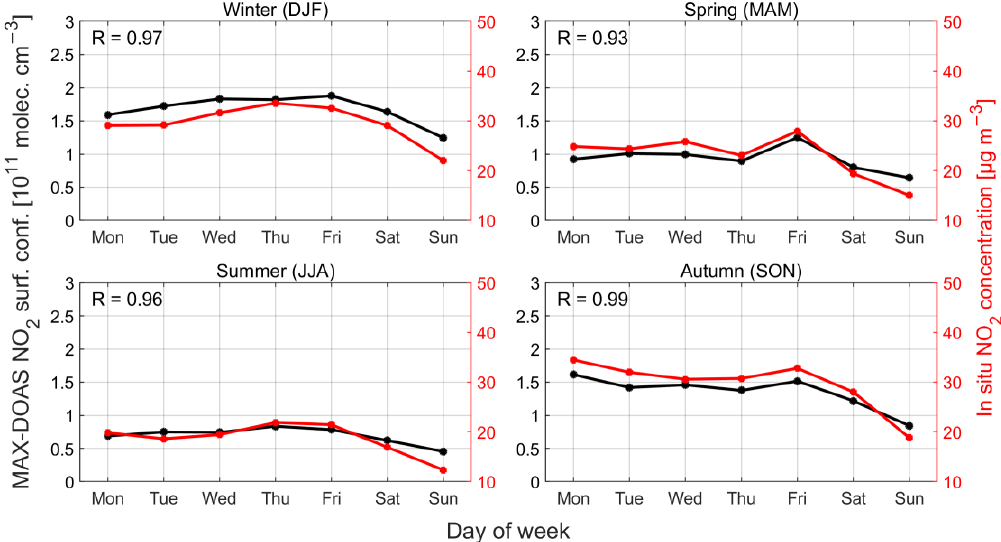
Figure 4. The day of week variability of NO 2 surface concentrations revealed by the MAX-DOAS (black) and the in situ (red) measurements for all seasons.